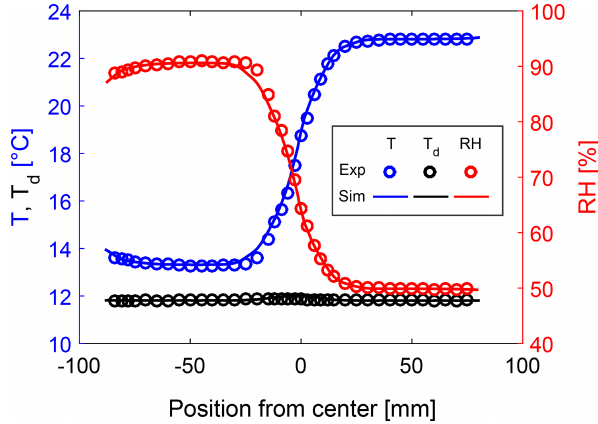
Figure 7. Dew-point temperature (black markers), temperature (red markers) and RH profiles (blue markers) including the simulation results, for (cid:49)T = 10K and (cid:49)T d = 0K obtained at z 3 .